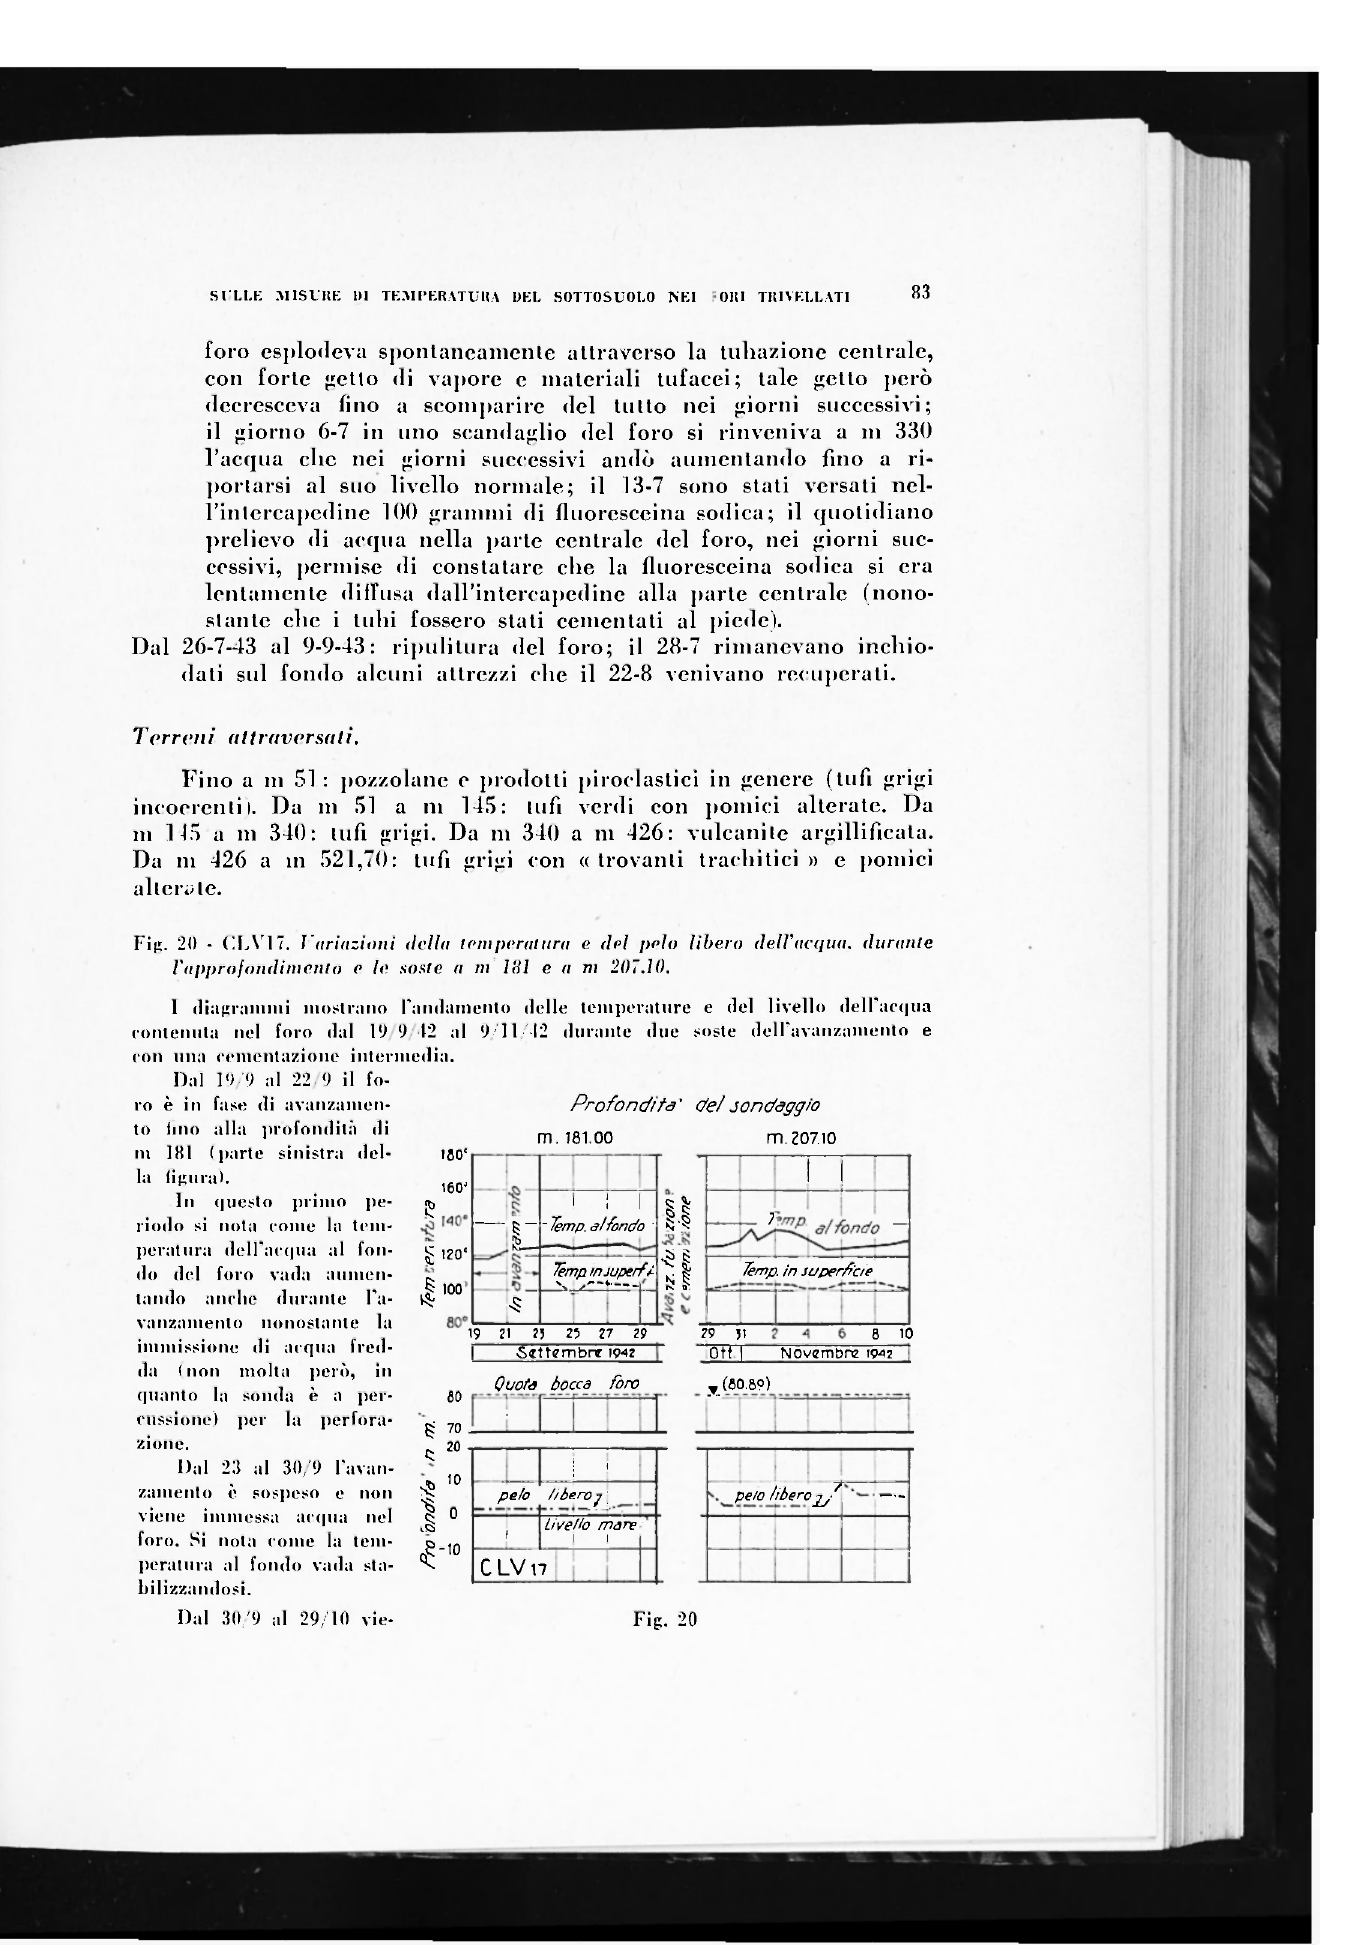
Fig. 20 - CLV17. I ariazioni (Iella temperatura e del pelo libero dell'acqua, durante l'approfondimento e le soste a m IMI e a ni